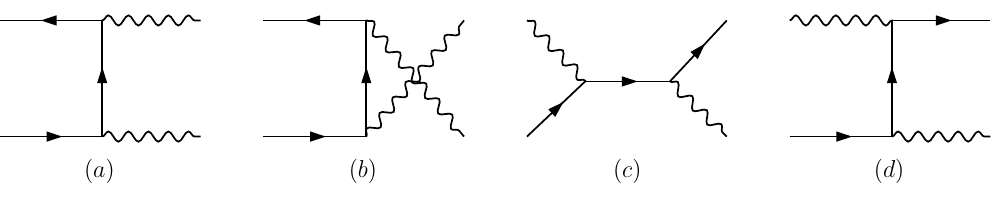
A ) via Feynman diagrams ( a ) - ( b ) T T